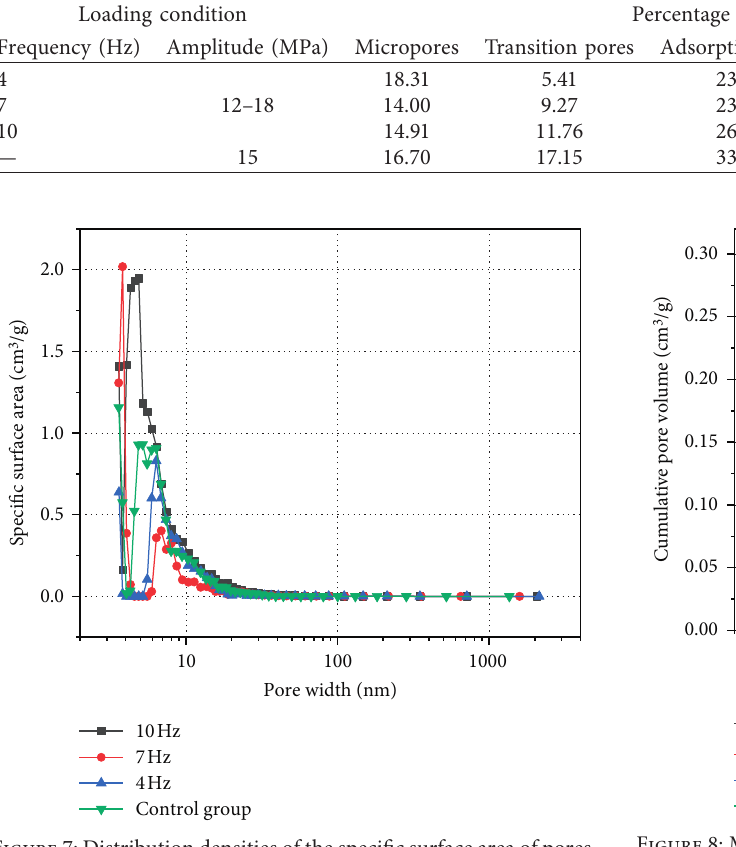
Figure 7: Distribution densities of the specific surface area of pores in coal mass at different loading frequencies.